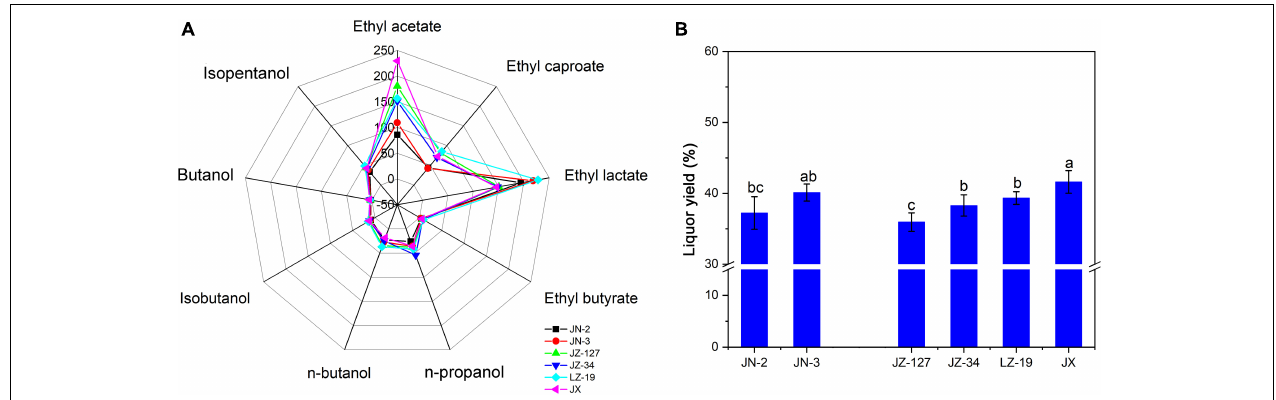
FIGURE 1 | Volatile compounds of liquor (A) and liquor yield (B) in two waxy (JN-2 and JN-3) and four non-waxy sorghum varieties (JZ-127, JZ-34, LZ-19, and JX). Different letters indicate significant differences (ANOVA, P < 0.05) amongst various sorghum varieties.